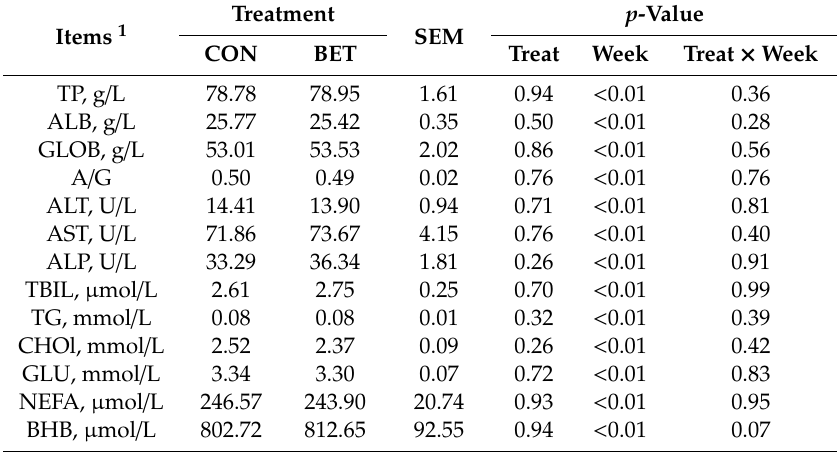
Table 3. Effectsofsupplementingcowswithoutrumen-protectedbetaine(CON)orwithrumen-protected betaine (BET) on blood metabolites from four weeks before expected calving to six weeks postpartum. Treatment Items 1 SEM